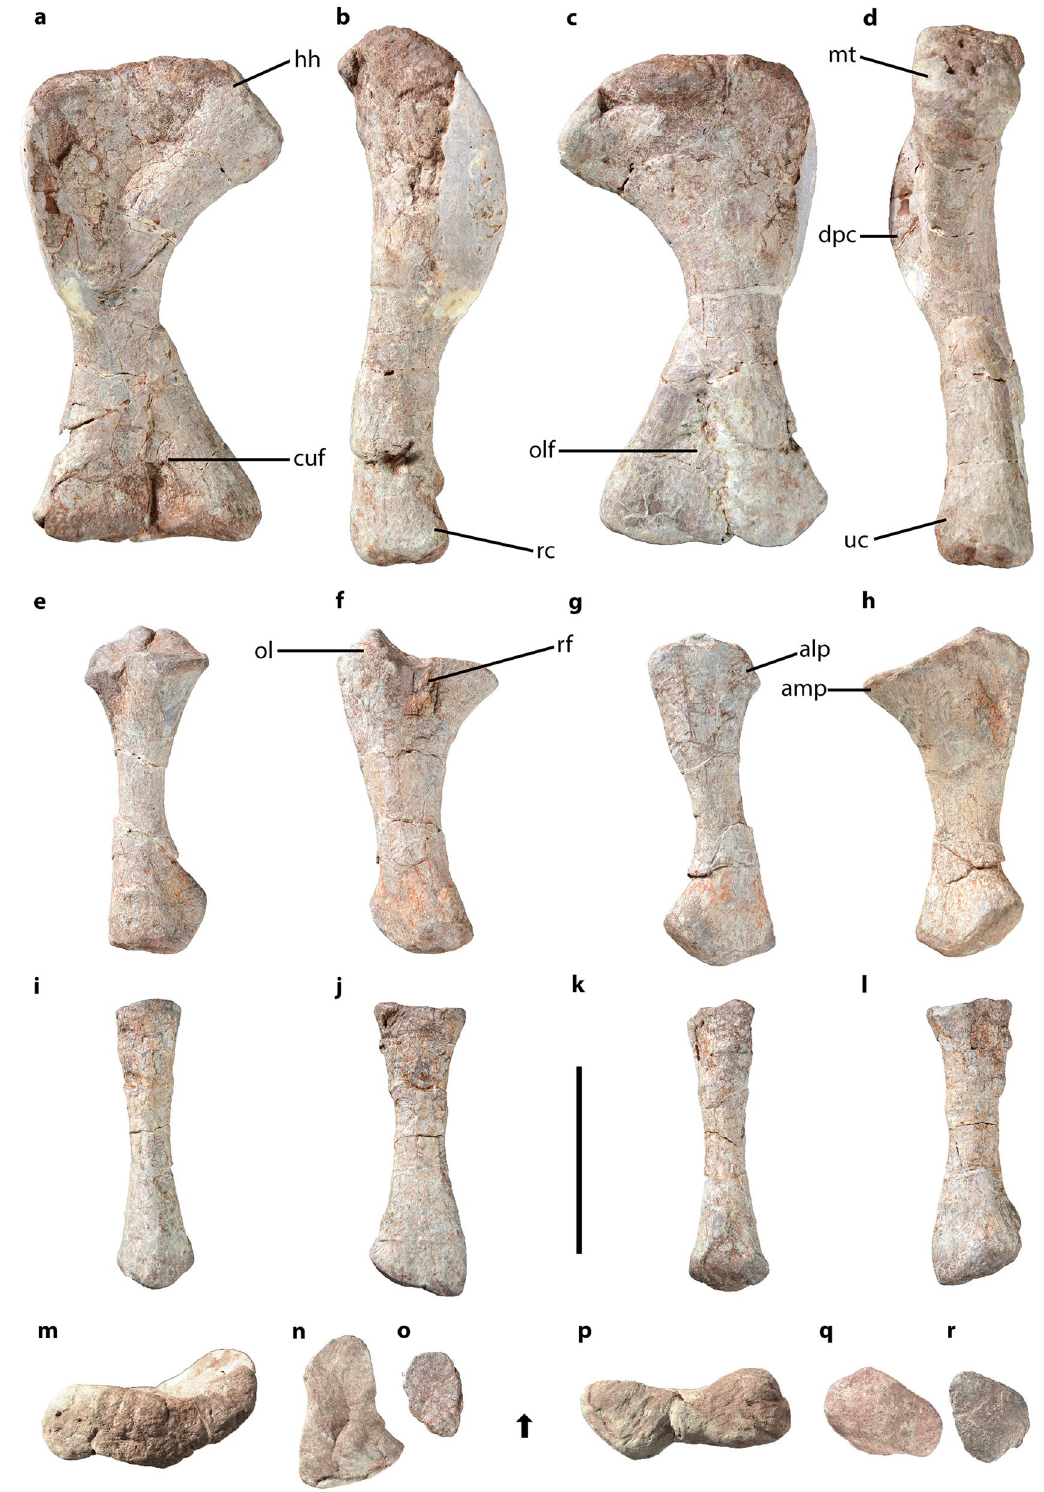
Figure 9. Irisosaurus yimenensis right humerus, ulna and radius in, from left to right: anterior, lateral, posterior and medial views. Proximal and distal views on the last line. ( a–d , m , p ) Humerus; ( e–h , n , q ) Ulna; ( i–l , o , r ) Radius. Abbreviations: alp, anterolateral process; amp, anteromedial process; cuf, cuboid fossa; dpc, deltopectoral crest; hh, humerus head; mt, medial tuberosity; ol, olecranon; olf, olecranon fossa; rc, radial condyle; rf, radial fossa; uc, ulnar condyle. The arrow indicates the anterior surface of bones for ( m – r ). Scale bar = 10